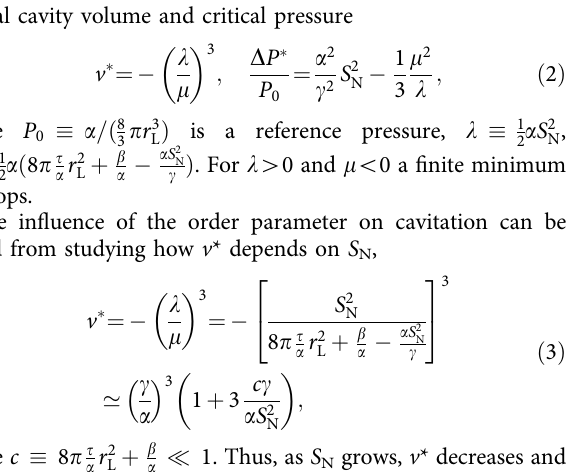
Figure 8 | Microfluidic confinement. ( a ) Microchannel with micron-sized cylindrical pillar fabricated using surface bonding of PDMS and glass components. The orthographic projection shows a linear channel of a rectangular cross-section with the integrated micropillar. The x , y and z coordinates denote the flow direction of the anisotropic fluid (a nematic molecule), the transverse direction of the channel (width) and the channel depth, respectively. The blue arrowheads show the flow path. ( b ) Microchannel projection showing the cross-sectional view ( yz plane) with r , w and d being the pillar radius, channel width and depth, respectively. ( c ) Sketch of the empty simulation channel with the discrete